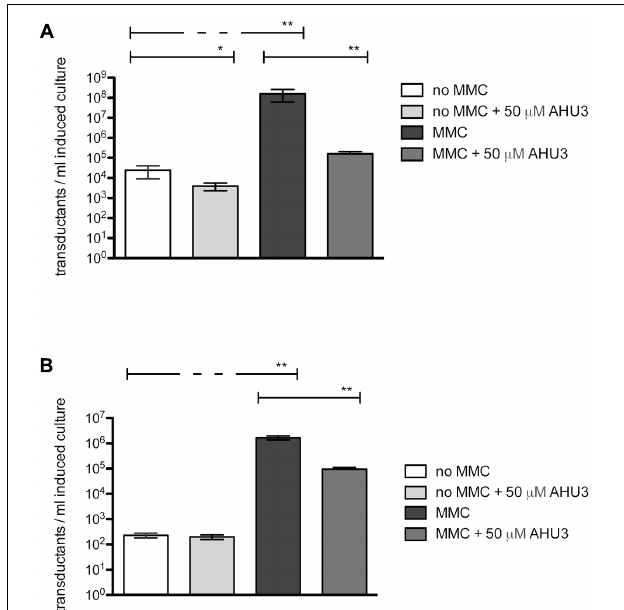
FIGURE 5 | Reduction of MMC-induced phage production by 50 µ M AHU3. (A) Induction of JP10819 with 2 µ g/ml MMC resulted in significantly increased Stx phage production. Addition of 50 µ M AHU3 produced a significant decrease in phage production by both non-induced and MMC-induced JP10819. The interaction between MMC and AHU3 was determined to be significant ( p < 0.001), implying that the reduction in phage production by MMC-induced cells observed is not the result of the inhibitory effect of AHU3 on bacterial growth. (B) Induction of JP5011 with 2 µ g/ml MMC resulted in significantly increased SLT phage production. Addition of 50 µ M AHU3 produced a significant decrease in phage production by MMC-induced JP5011. Asterisks indicate a significant difference ( ∗ p < 0.05, ∗∗ p < 0.001) in phage production between the groups indicated by capped lines. The data shown are the average of triplicate individual experiments with standard deviation from the mean displayed as error bars. Statistical significance was determined by GLM